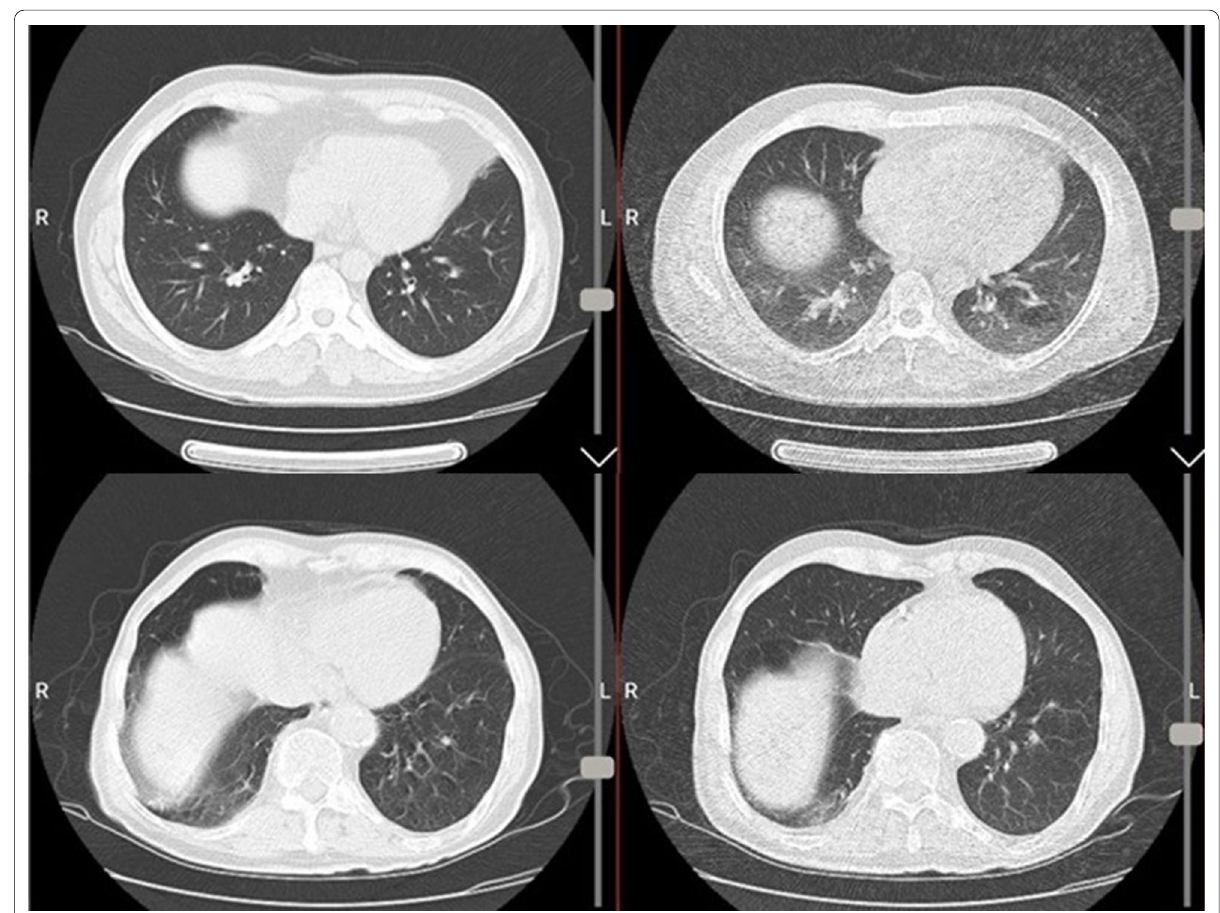
Fig. 2 Examples of false positive read‑out in ultra‑low‑dose protocol (upper row‑right image) which was due to scan in expiratory‑phase resulted in accentuated air‑trapping and pseudo‑ground glass appearance and was normal in same section of low‑dose protocol (upper row‑left image). Similar artifact is present in ultra‑low‑dose images of another case with false read‑out of ground glass patch in right lung base (lower row‑right image) which was mild atelectasis in low‑dose section (lower row‑left image)